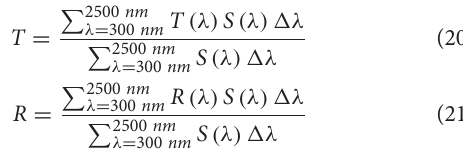
Frontiers in Materials |